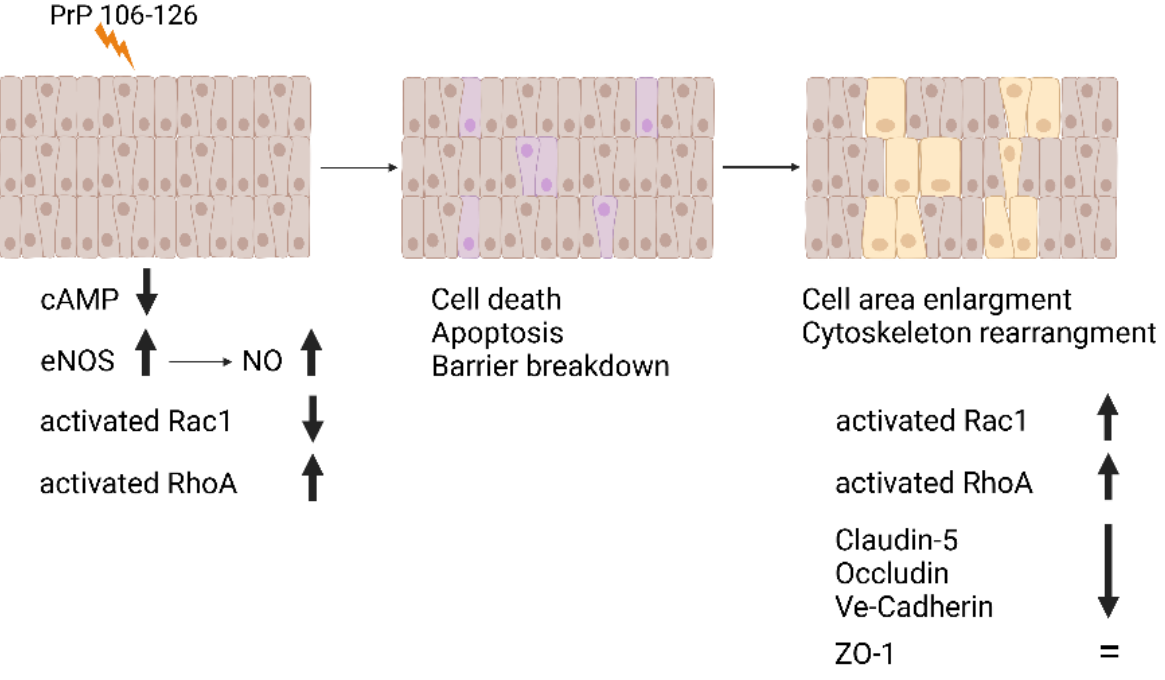
Figure 6. Schematic illustration of PrP 106-126-induced damage and endothelial compensating response. PrP 106-126 exposure to BEC results in cell death and apoptosis, reduction in TJ and AJ and partial loss of barrier function which are compensated by an enlargement of the endothelial cell territory rather than by cell replication [14]. This remodeling of the intercellular interactions of the remaining cells is mediated by activation and de-activation of the small GTPases Rac1 and RhoA which affect barrier integrity (Figure 3). Reduction in cAMP and elevation of eNOS and NO occur after exposure to PrP 106-126; The exact mechanism beyond the effects of these molecules on the robust changes observed in cytoskeleton proteins (Figures 4 and 5 and Supplementary Tables S1–S3) remains to be elucidated.